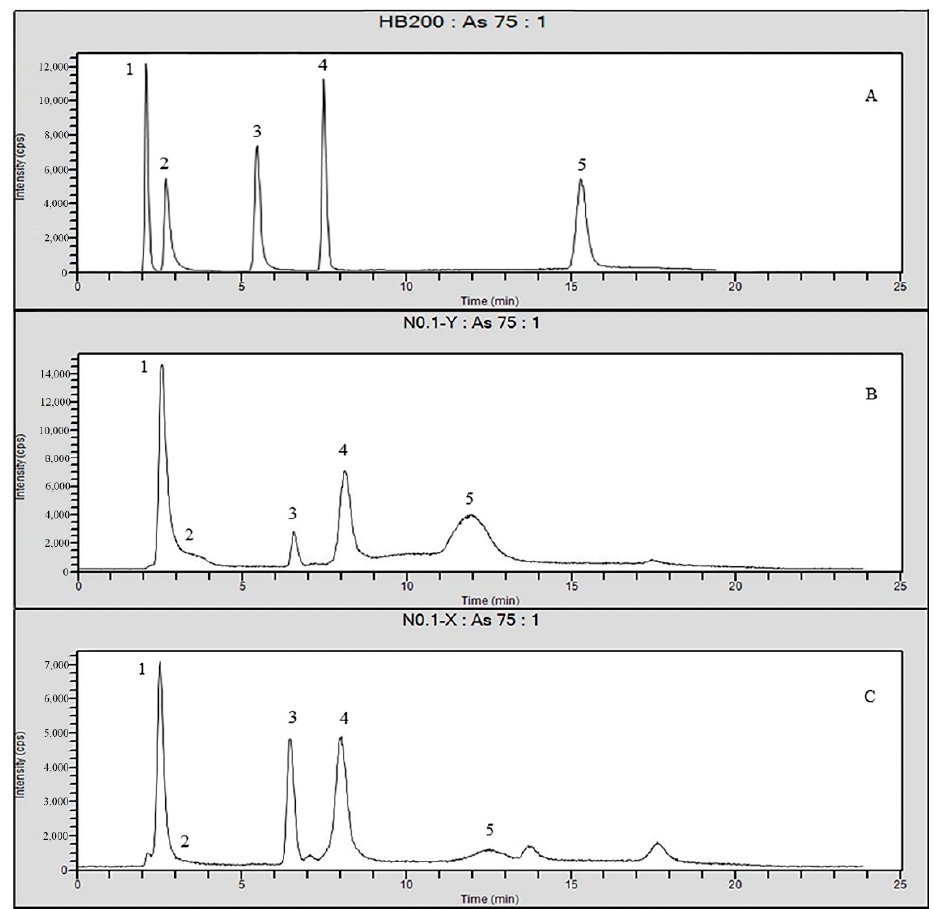
Figure 8. Chromatograms of HPLC-ICP-MS (( A ): Mixed standards, ( B ): Extract of Mactra veneriformis, ( C ): iowaite disposal of the Mactra veneriformis products; (Peak 1-AsB; Peak 2-As 3+ ; Peak 3-DMA; Peak 4-MMA; Peak 5-As 5+ ).